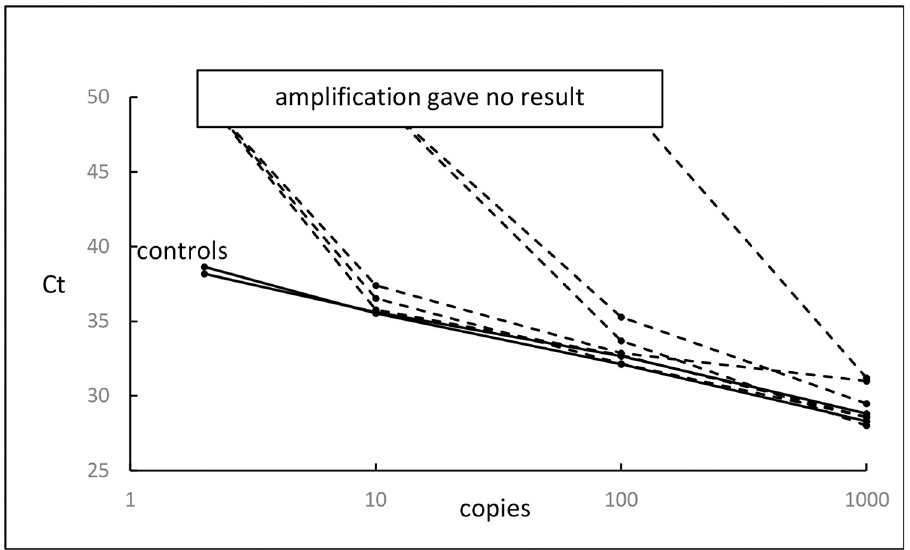
Fig 2. Effect of test primers on amplification of plasmid target in the presence of DNA. The effect of a primer pair from each of 6 patients on amplification of different numbers of plasmid sequences in the presence of 0.5 μ g of genomic DNA was determined. Control reactions, which contained only the plasmid primers, are the solid lines, and the test reactions, which contained both the plasmid primers and a pair of patient primers, are the broken lines.